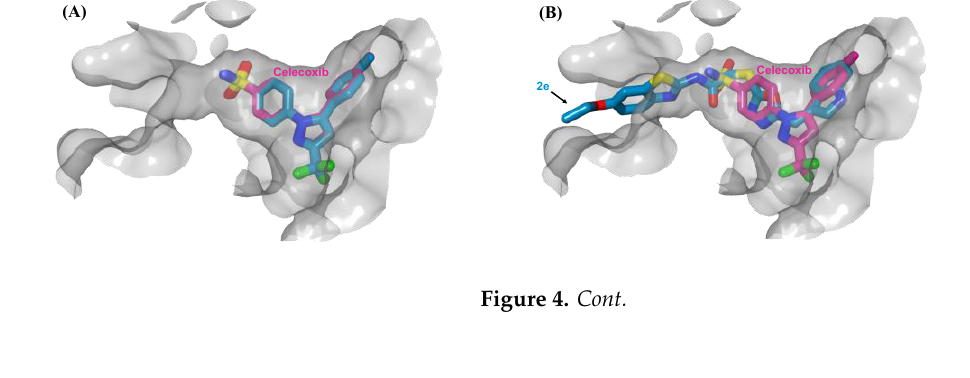
Figure 4. The top-scoring docked pose of compound 2e bound to the active site of COX-1 (PDB code 3KK6). The active site is displayed in surface view (light grey). ( A ) Comparison of modeled binding mode of the co-crystallized ligand celecoxib (magenta sticks) and its superimposed docking conformation (cyan sticks). ( B ) Comparison of modeled binding mode of compound 2e (cyan sticks) and celecoxib (magenta sticks). ( C ) Detailed binding mode of compound 2e (cyan sticks) displaying hydrogen bonds (black dashed line) and CH –π interaction (red dashed line) with the critical amino acid residues (white sticks). ( D ) Two-dimensional depiction of compound 2e binding interactions with the essential amino acid residues.